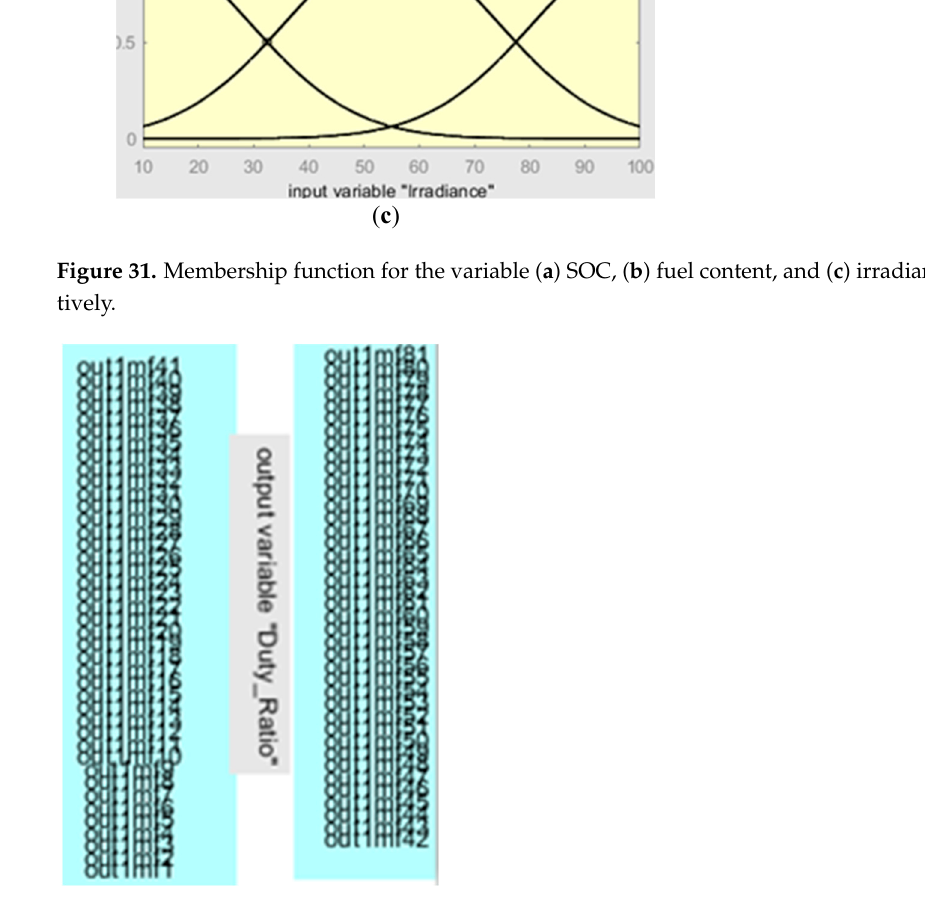
Figure 33. Output variable relay membership functions.